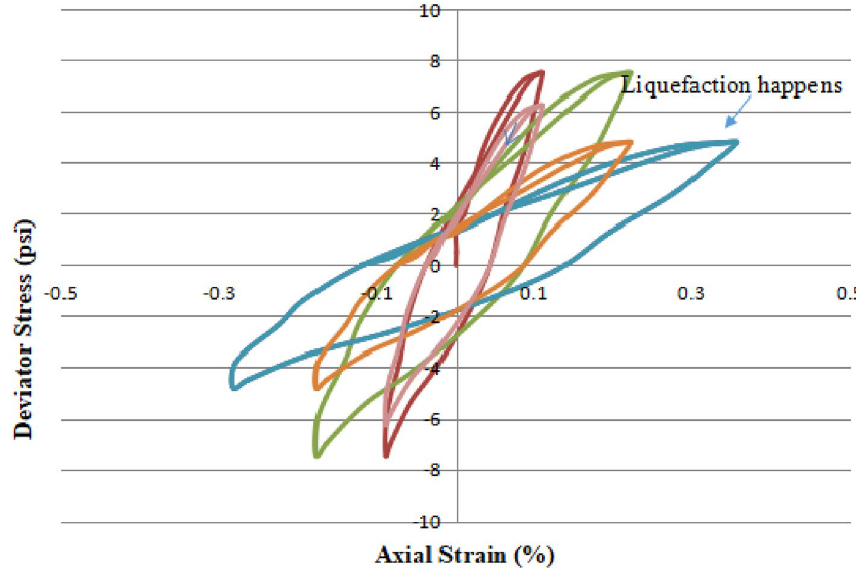
Figure 12. Deviator stress versus axial strain in cyclic triaxial test.